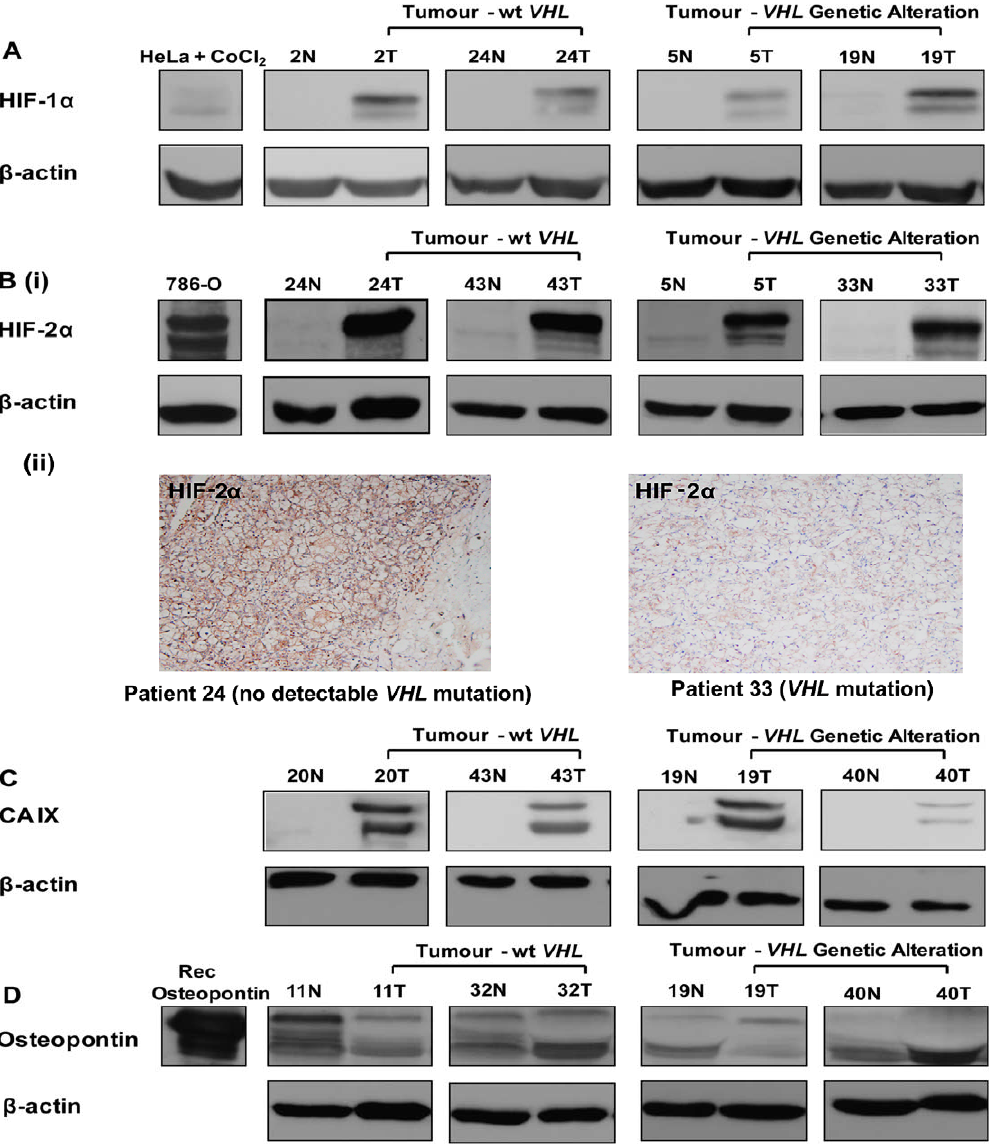
Fig. 2. HIF-1 α , HIF-2 α , CAIX and osteopontin expression in paired CCRCC tissue samples. Western blot analysis of HIF-1 α (A), HIF-2 α (B(i)), CAIX (C) and osteopontin (D) expression in paired normal renal and tumour tissue protein lysates. (B(ii)) Immunohistochemical analysis of HIF-2 α expression in CCRCC paraffin embedded tissue sections. The positive control for HIF-1 α is a protein lysate prepared from hypoxic HeLa cells (hypoxia induced with 75 µM CoCl 2 for 16 h). In the case of HIF-2 α , the positive control is a protein lysate from the 786-O renal cancer cell line (this is a pVHL deficient cell line which constitutively expresses HIF-2 α ). Osteopontin in renal tissues is expressed in the form of 72, 66 and 58 kDa protein bands [31]. Recombinant human osteopontin (R&D Systems) is a positive control for osteopontin. VHL genetic alterations were not detected in Patients 2, 11, 20, 24, 32 and 43 tumour tissues. VHL genetic alterations were identified in Patient 5, 19, 33 and 40 tumour tissues. β -actin was a loading control. N – normal; T –